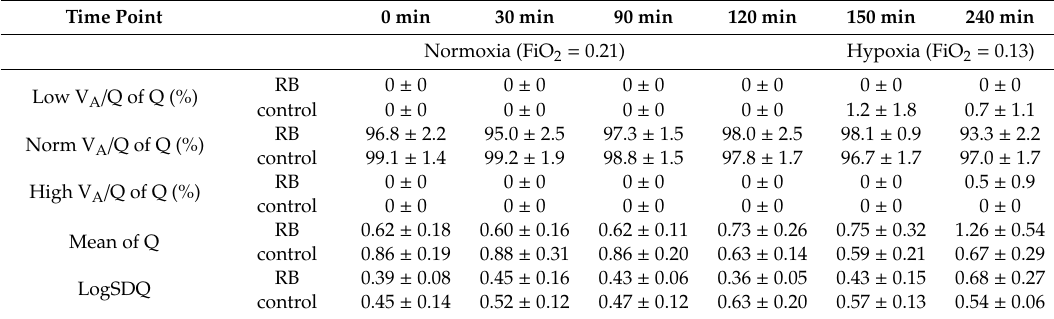
Table 3. Inert gas data ( n =